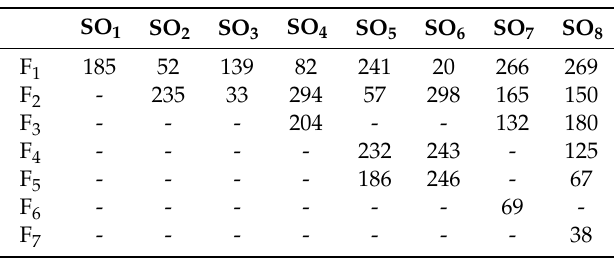
Table 4. Dependency matrix.